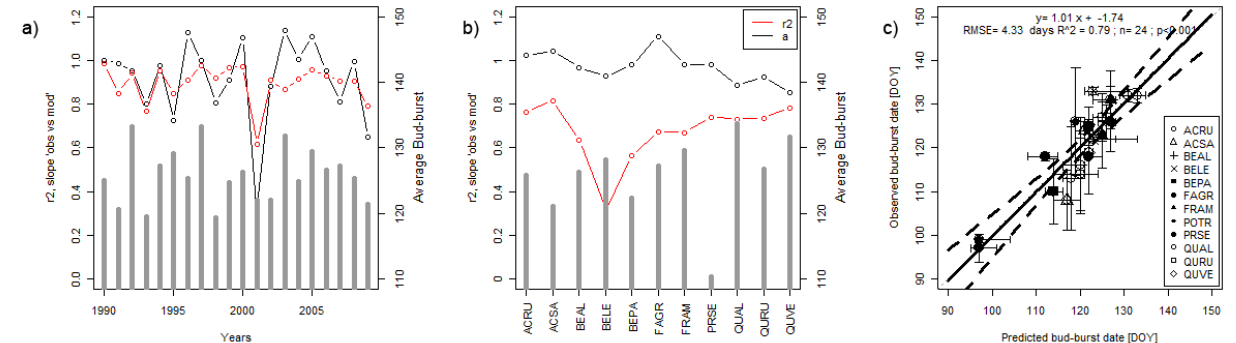
Fig. 4. Coefficient of determination ( R 2 ) and slope of the linear regression between observed and predicted bud-burst with the best model selected (Table 1) for each year (a) , for each species (b) . Vertical lines represent the average bud-burst day of the year in each year (a) and for each species (b) . Gray bars represent the average bud-burst dates across species (a) and the average bud-burst for each species (b) . (c) Predicted versus observed bud-burst dates for the years 2010–2011 simulated for the 11 species and the best model selected as described in Table 1. Error bars for the predictions represent the propagated uncertainty of model parameters while for the observed dates is the minimum and maximum bud-burst dates observed for each individual.